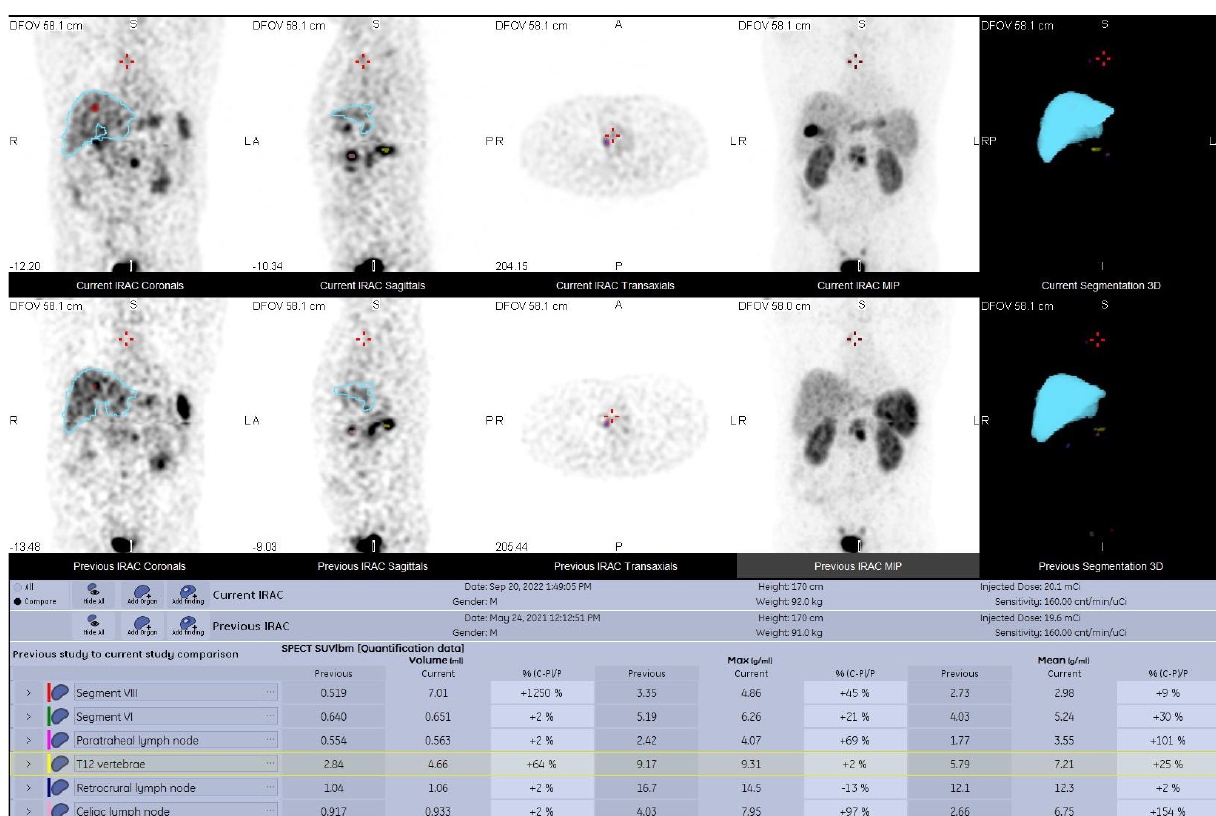
Figure 3. Comparison between a baseline and a follow − up scan of a 56 − year − old male patient, diagnosed with an intestinal NET, grade G1, with hepatic, lymphatic and osseous metastases. The patient had been following treatment with long acting SSA. Although the liver metastasis and the paratraheal and celiac lymph nodes presented a notable increase in 99m Tc − EDDA/HYNIC − TOC uptake, the final assessment of the follow-up study established that the patient had stable disease (SD).